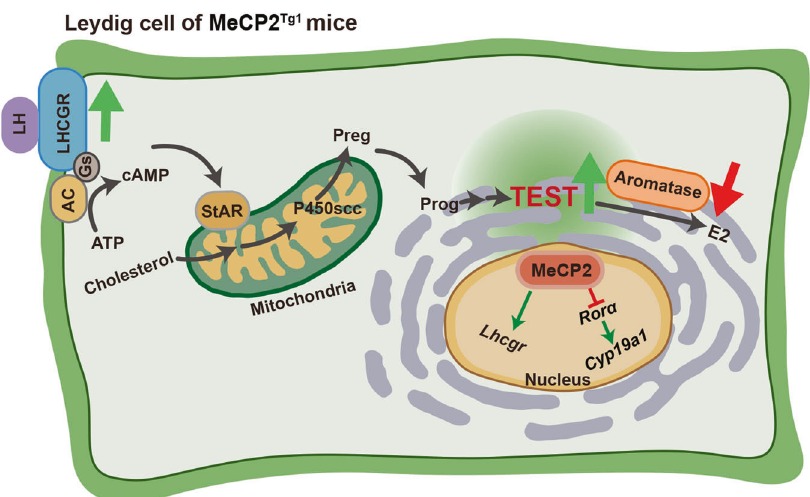
Fig. 7 Schematic illustration for MeCP2 regulating androgen via LHCGR and aromatase. The illustration shows MeCP2 regulates its target genes ( Lhcgr , Ror α ) in the nucleus of the Leydig cell. The bold arrows (green or red) indicate that MeCP2 is involved in the testicular steroidogenesis by upregulating LHCGR and downregulating aromatase. TEST,